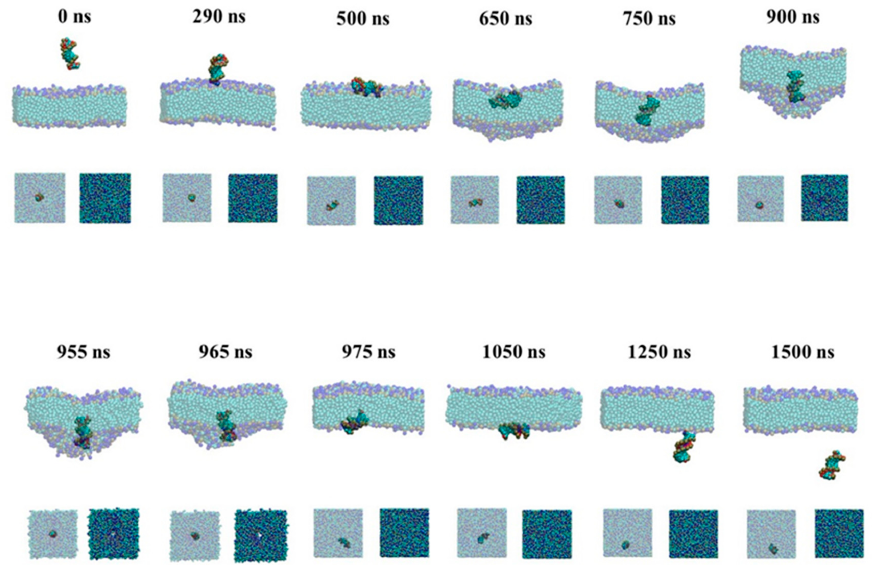
Figure 2. Snapshots of active transmembrane process of the naked siRNA. The major graphs are front view of process and the small graphs are upper view.